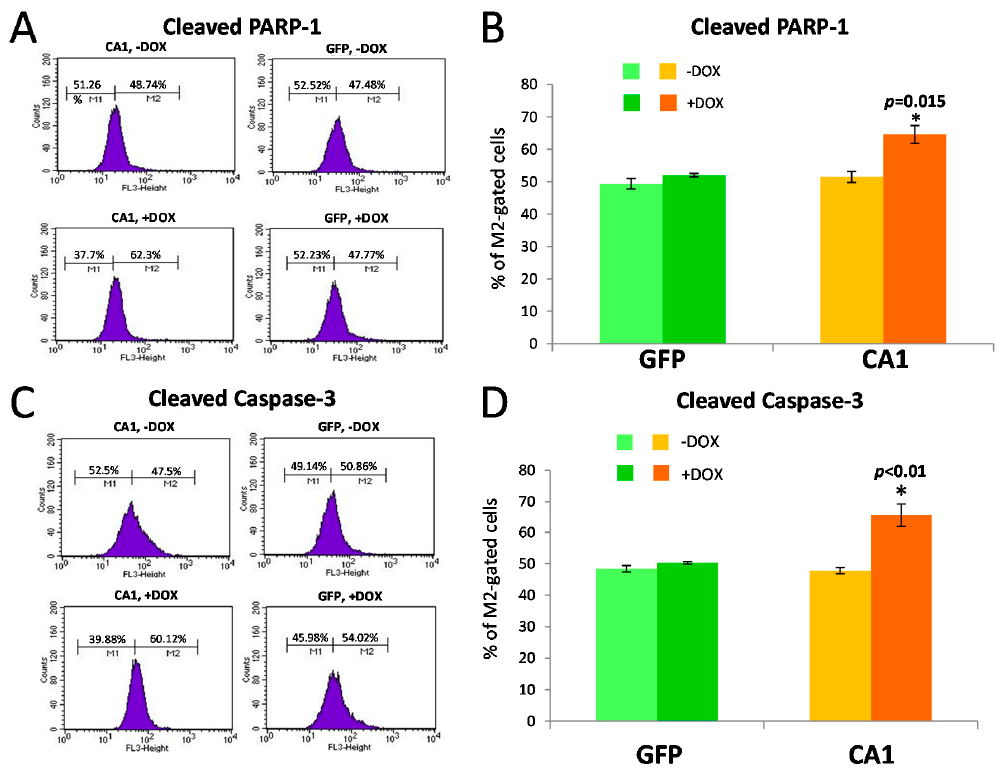
Figure 6. Expression of CA1 in HEK293 cells induces activation of apoptosis indicated by the cleavage of both PARP-1 and Caspase-3. CA1 expression was induced by 0.25 μ g/mL doxycycline (DOX) for 96 h and HEK293 cells were analyzed via FACS using PARP-1 and Caspase-3 antibodies which recognized only cleaved protein fragments, in absence ( − ) or presence (+) of DOX. The expression of GFP was used as the control. ( A , C ) Representative FACS profiles of measuring cleaved PARP-1 ( A ) and cleaved Caspase-3 ( C ) in HEK293 cells; The histogram is plotted with the cleaved Caspase-3 or cleaved PARP-1 fluorescent intensity ( x -axis) against cell counts ( y -axis). M1 and M2 gates mark the cell population used to observe the fluorescence shift across the x -axis. The percentage of the cells in M1 and M2 was indicated directly above the gated line; ( B , D ) Bar graphs representing the degrees of PARP-1 ( B ) and Caspase-3 ( D ) cleavage as indicated by the percentage of M2 gated cells. The data are the average of three independent experiments and expressed as “Mean ± SEM”. * indicates p value < 0.05.